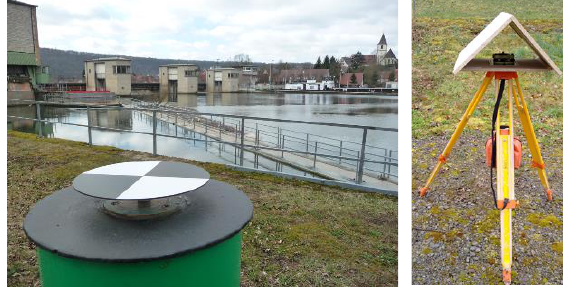
Figure 2. Ship lock and photogrammetric control point (PCP) on a pillar ( left ), LiDAR control plane (LCP) ( right